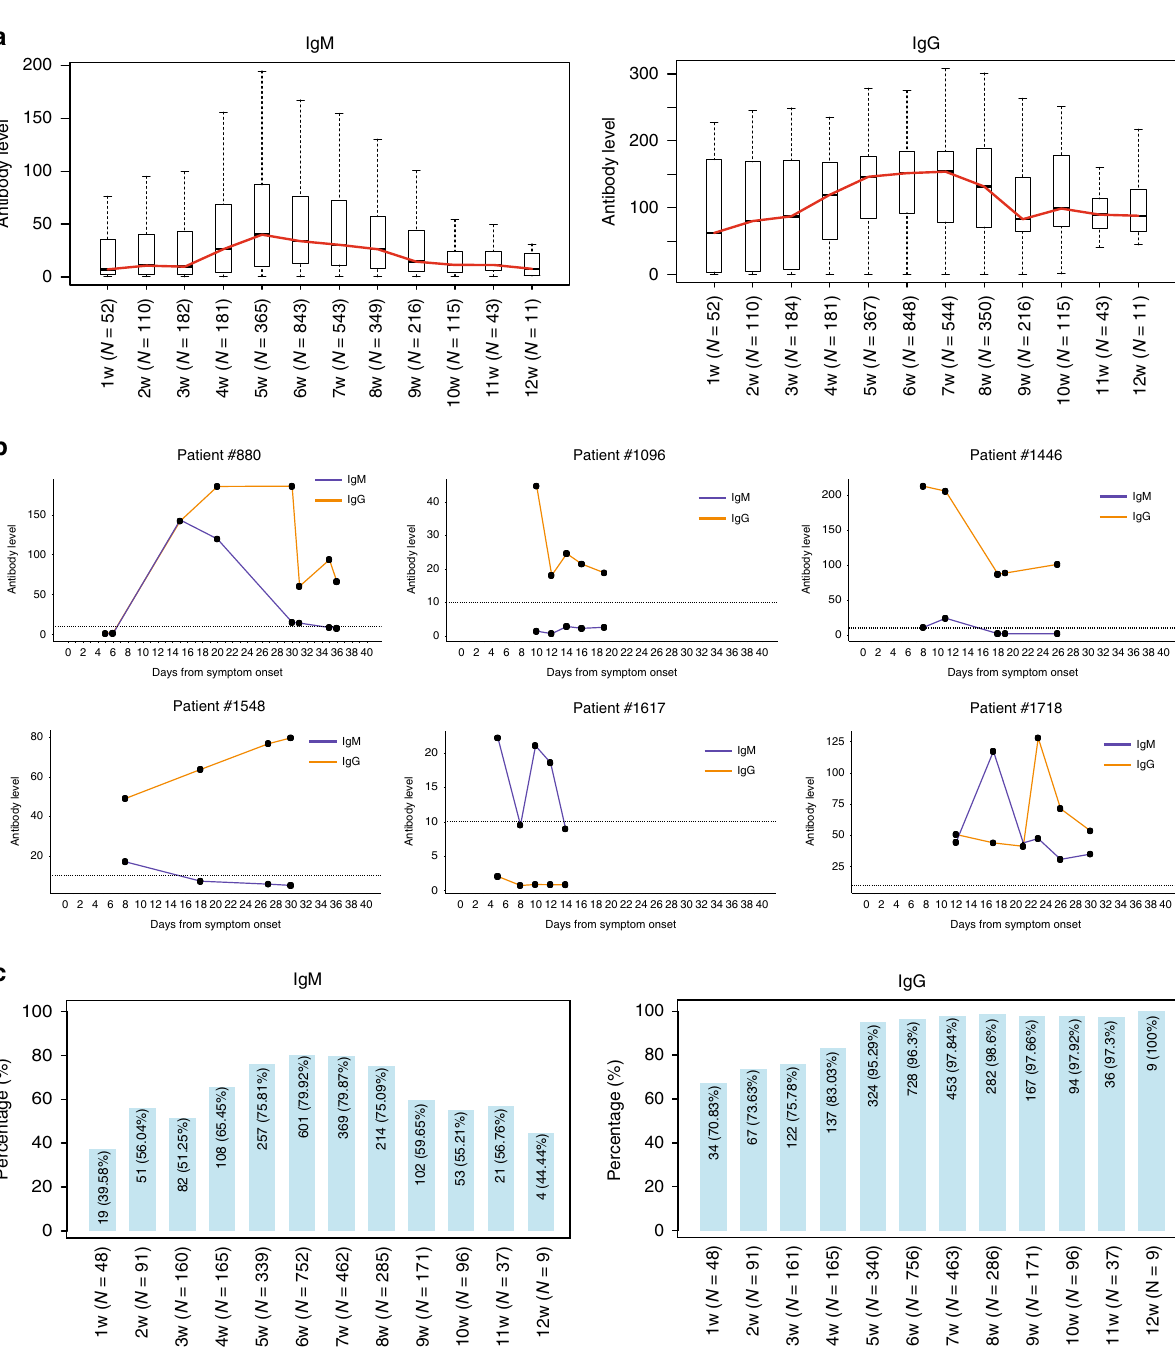
Fig. 1 Temporal dynamic changes of the total anti-SARS-CoV-2 IgM and IgG. a The total anti-SARS-CoV-2 IgM and IgG level of con fi rmed COVID-19 patients from the fi rst to 12th week after symptom onset. Horizontal lines in the boxplots represent the median, the lower, and the upper hinges correspond to the fi rst and third quartiles, and the whiskers extend from the hinge up to 1.5 times the interquartile range from the hinge. The red line based on the median is used to pro fi le the variation tendency. b The temporal dynamic changes of the antibody levels in six representative patients. The X axis represents the days since symptom onset, and Y axis represents the antibody level. c The prevalence of total anti-SARS-CoV-2 IgM and IgG. The X axis indicates the weeks after symptom onset, and the Y axis shows the antibody-prevalence among con fi rmed COVID-19